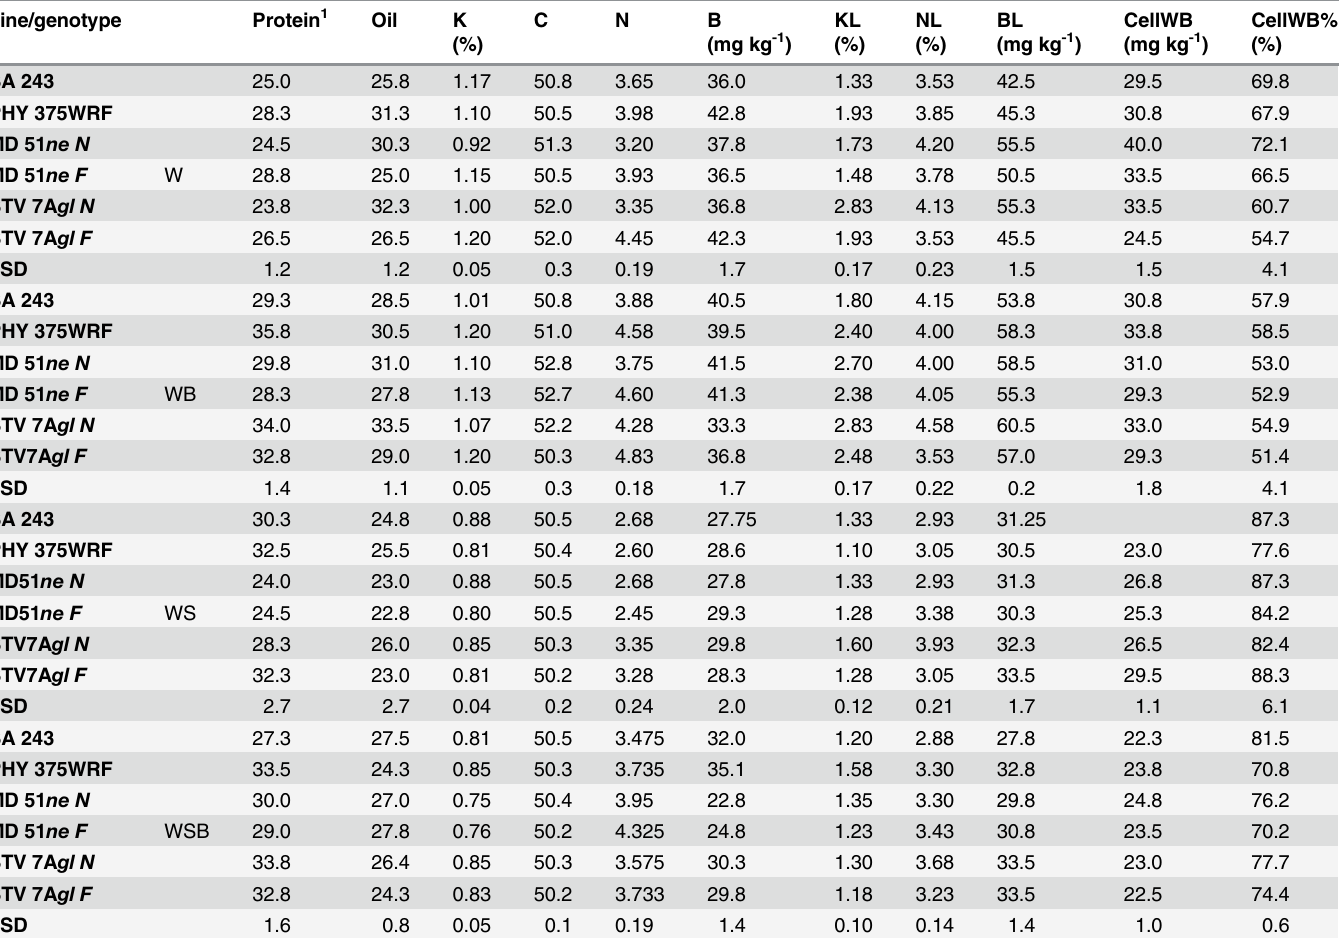
Table 4. Experiment 2: Effect of water (W) and foliar boron application (B) treatments on cottonseed nutrition (protein, oil, K, C, N, B) and nutrients (K, N, B) in leaves (L), and in cell wall B (CellWB), and cell wall B contribution to the total B (CellWB%) in near-isogenic lines expressing fuzzy (F) and fuzzless (N) seed